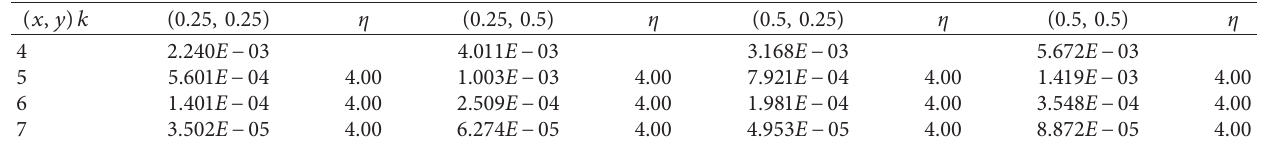
Table 2: The errors for finite difference solutions in the pointwise sense.